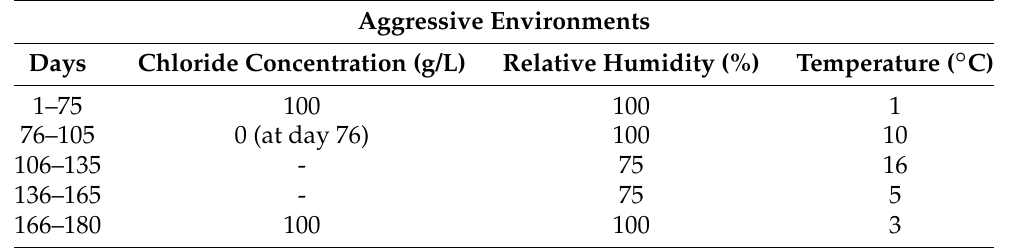
Table 3. The aggressive